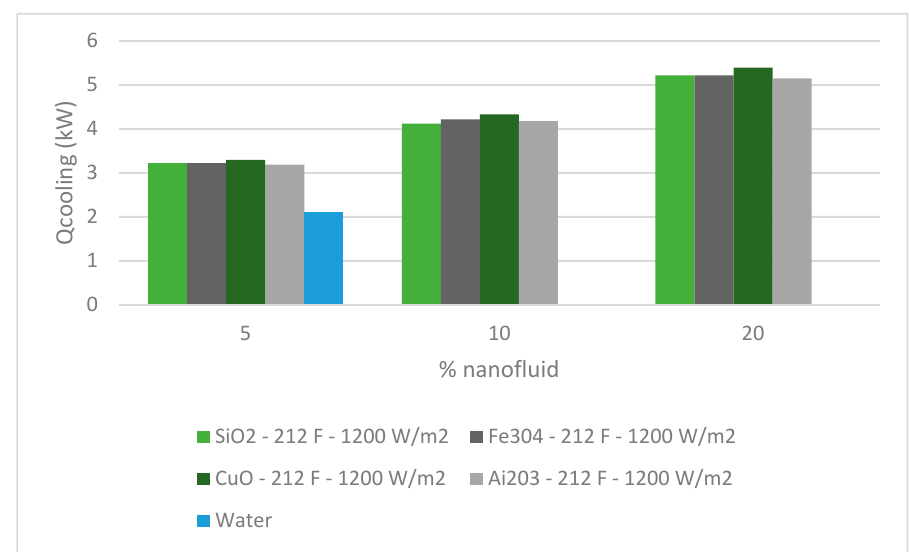
ff ect for di ff erent